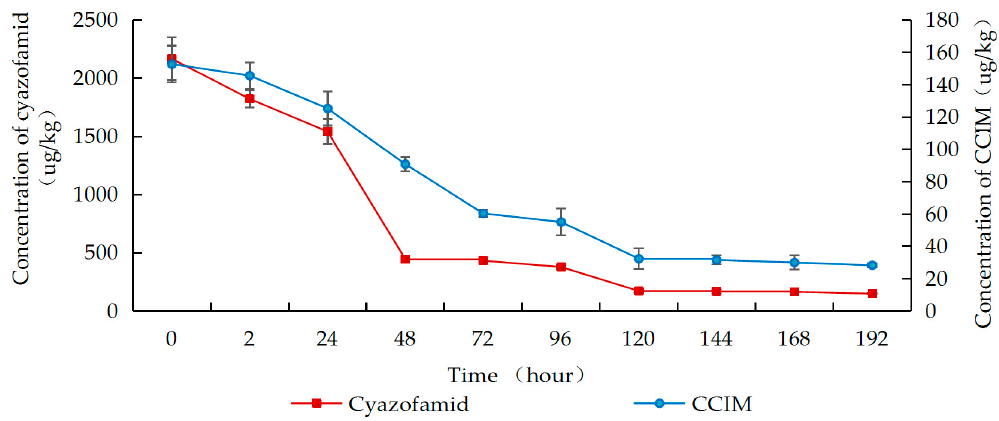
Figure 2. Concentrations of cyazofamid and CCIM in Group A during the wine-making process.